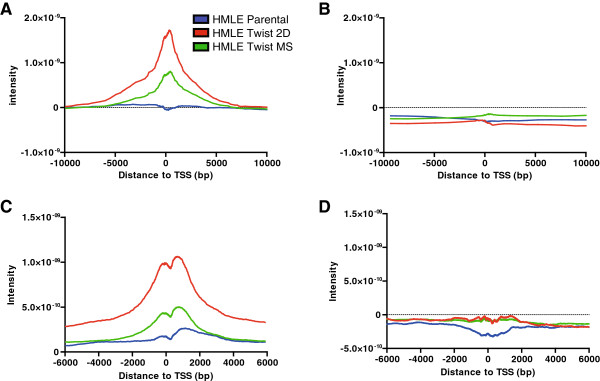
Correlation between DNA methylation and H3K27me3 mark. (A) During epithelial-mesenchymal transition (EMT), gain of DNA methylation (≥2%) at selected promoters in human mammary epithelial (HMLE) Twist cells cultured either in monolayer (green) or spheres (red) and which were completely unmethylated (≤1%) in HMLE vector cells (blue) is accompanied by gain of the H3K27me3 mark. The x-axis represents distance from the CpG sites gaining DNA methylation to the transcription start sites (TSS). The y-axis represents average intensity of H3K27me3 peaks. (B) During EMT, loss of DNA methylation (≤2%) of selected promoters in HMLE Twist cells cultured either in monolayer (green) or spheres (red) and which were methylated in HMLE vector cells (blue) is not associated with change of H3K27me3 distribution. The x-axis represents distance from the CpG sites losing DNA methylation to the TSSs. The y-axis represents average intensity of H3K27me3 peaks. (C) Distribution of H3K27me3 marks in partially methylated domain (PMDs) in HMLE Twist cells cultured in a monolayer (green) and spheres (red) as compared to HMLE vector cells. (D) Distribution of H3K27me3 marks outside PMDs in HMLE Twist cells either cultured in a monolayer (green) or as spheres (red) as compared to HMLE vector cells.